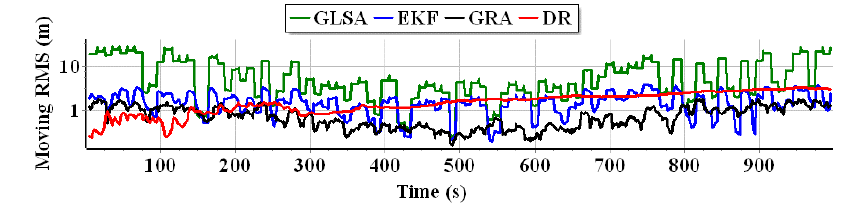
Figure 20. Moving RMS of the distance to the reference position from the estimated position during a single SV crossing as a function of time (logarithmic scale—log base = 10).